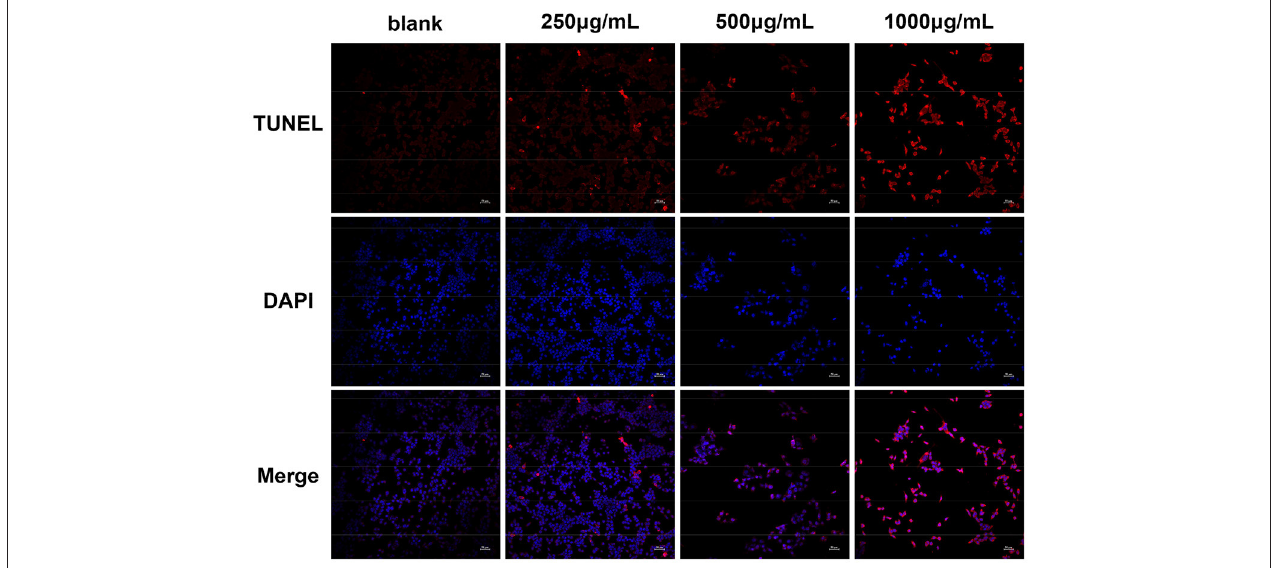
FIGURE 8 | Effect of DOME on cell apoptosis in Lovo cells. The cell apoptosis was determined using TUNEL assay, TUNEL-positive nuclei in red fluorescent color, and total nuclei staining with DAPI. Scale bar: 50 µ